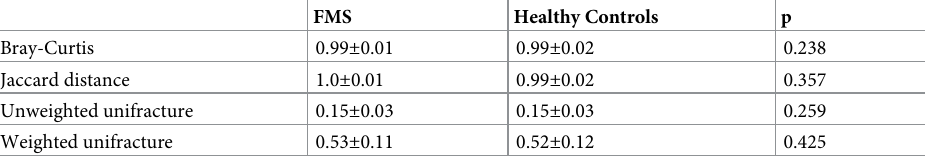
Table 3. Statistical analysis of microbial beta-diversity in FMS patients vs healthy controls. FMS Healthy Controls p Bray-Curtis 0.99 ± 0.01 Jaccard distance Weighted unifracture 0.53 ±